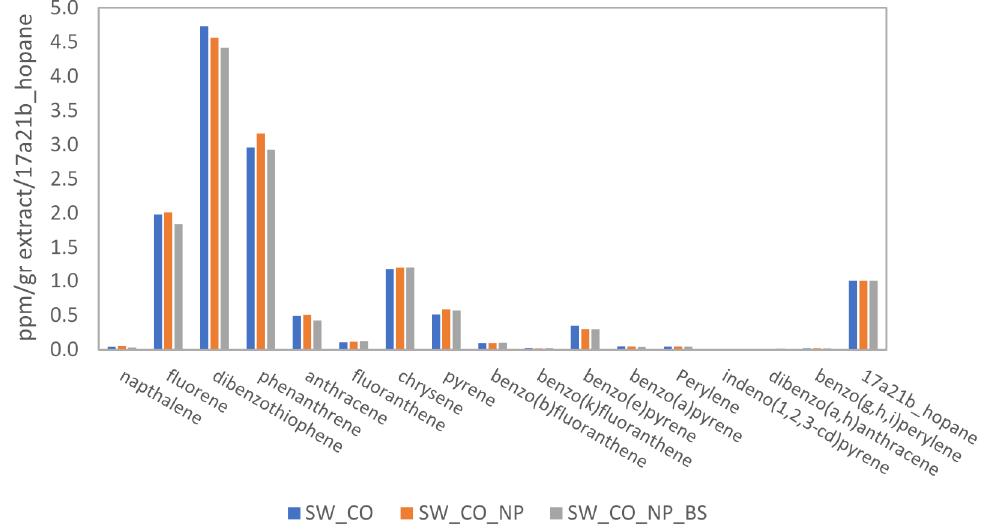
Figure A4. Bioremediation test results. Aromatic hydrocarbons concentration after 7 days of bio-